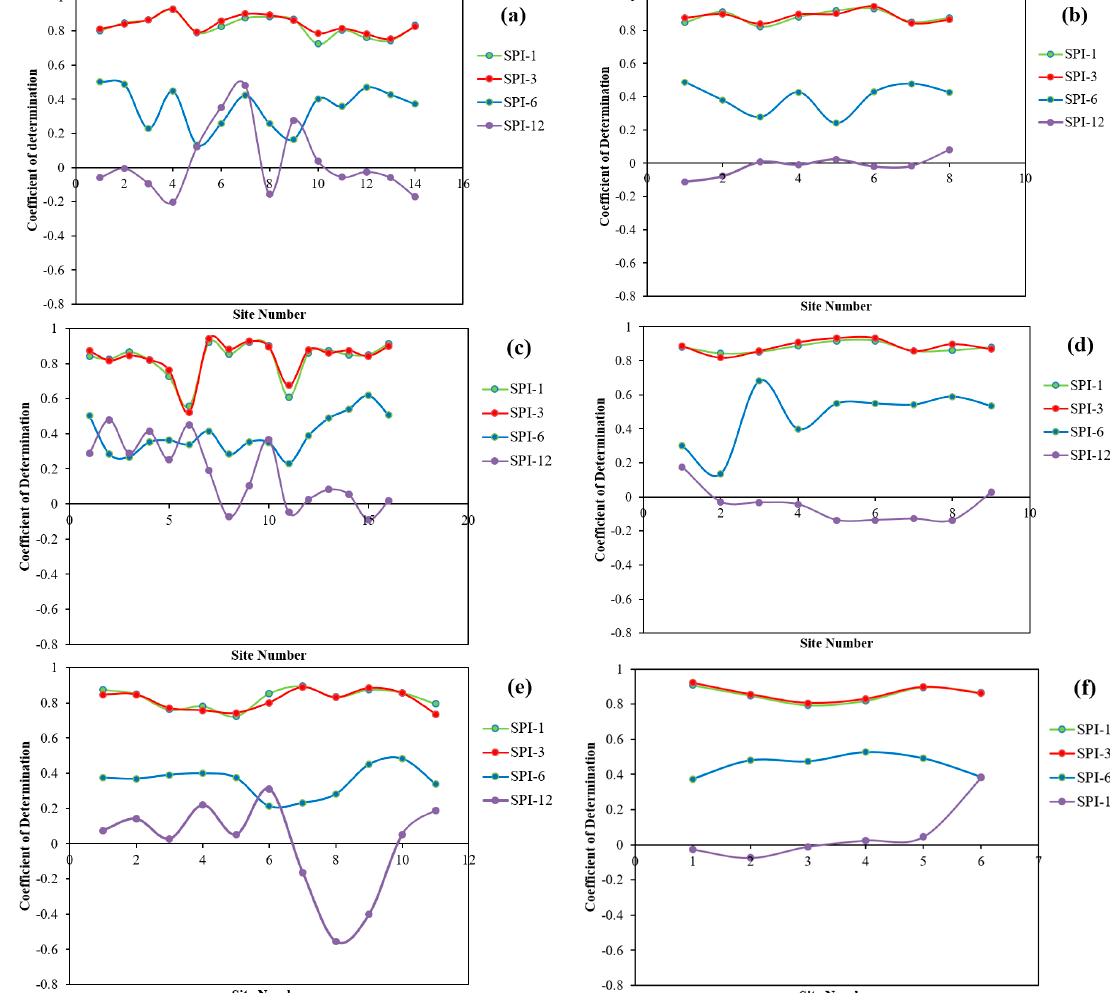
Figure 7. Coefficient of determination R 2 between two datasets for difference regions: ( a ) Northeast; ( b ) Huang–Huai–Hai; ( c ) MLRY; ( d ) South; ( e ) Sichuan basin; ( f ) Southwest.